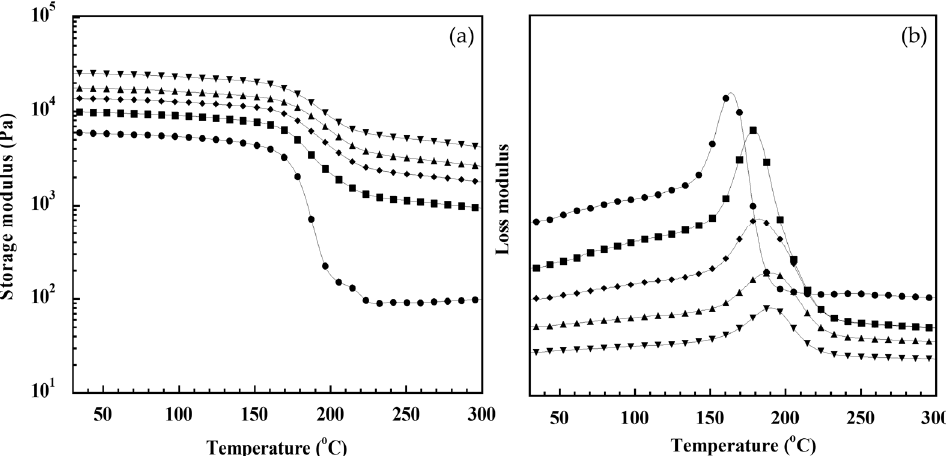
Figure 4. ( a ) Storage modulus ( b ) loss modulus of GF-reinforced poly(BA-a) composites at various